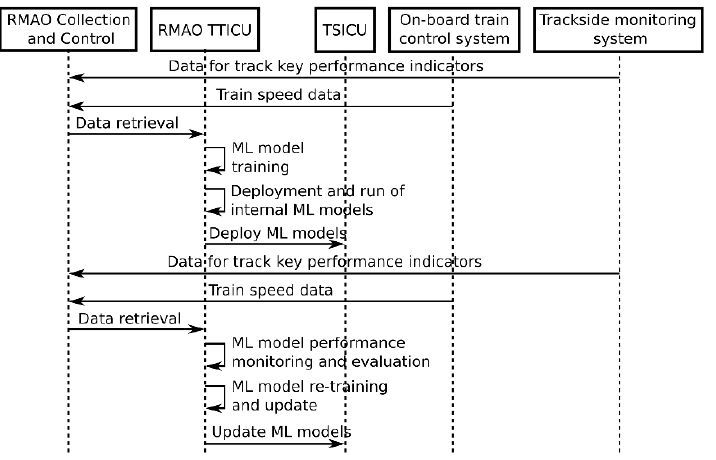
Figure 2. Training, deployment, and updating of the ML model for track